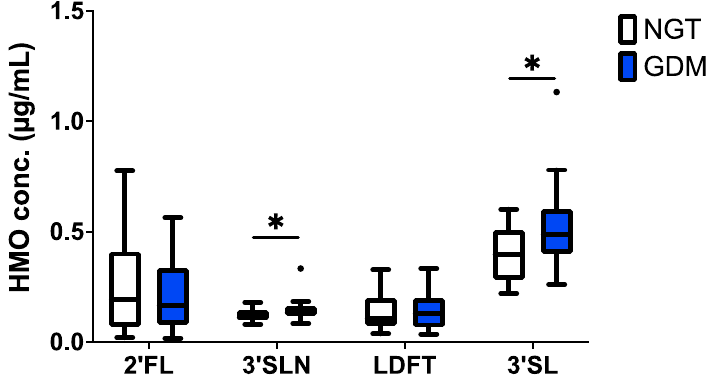
Figure 1. HMO concentrations in cord blood serum are different after GDM pregnancy. Tukey box- and-whiskers plot shows 2 ′ -fucosyllactose (2 ′ FL), 3 ′ -siallylactosamine (3 ′ SLN), lacto-difucotetraose (LDFT) and 3’-sialyllactose (3 ′ SL) concentrations in cord blood from pregnancies with normal glucose tolerance (NGT, open boxes) and GDM (blue boxes). NGT control n = 25, GDM n = 26; significance was determined by the Mann–Whitney-U-test; * p < 0.05.